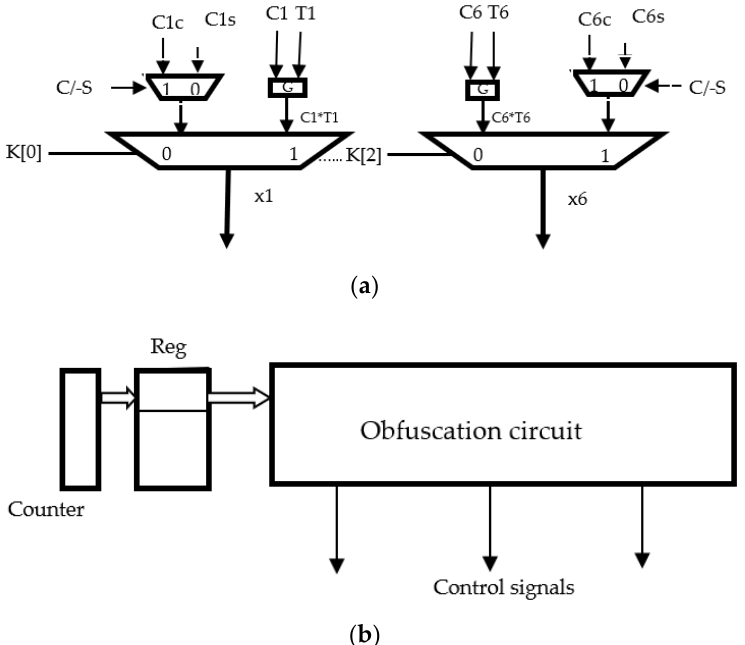
Figure 11. ( a ) Time-varying obfuscation. ( b ) Obfuscation circuit.